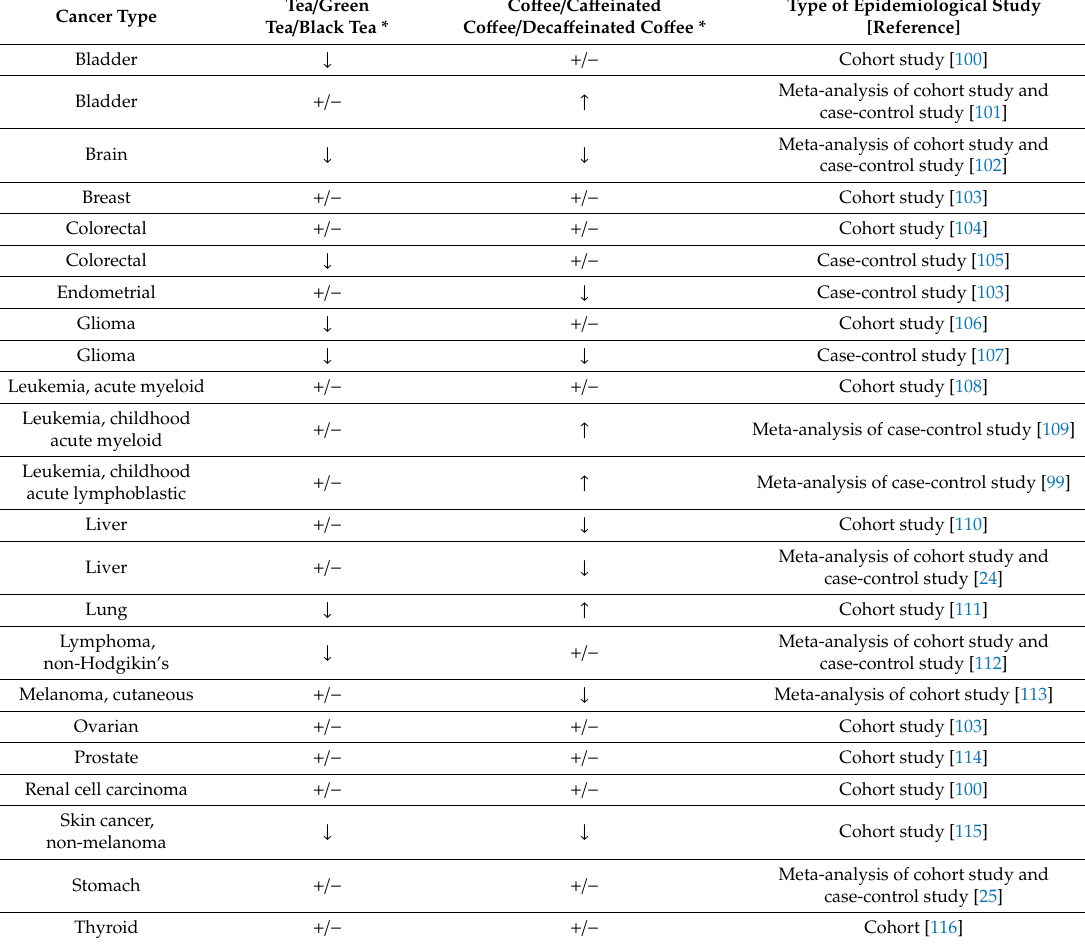
Table 2. Comparison of anticancer e ff ects in humans between tea and co ff